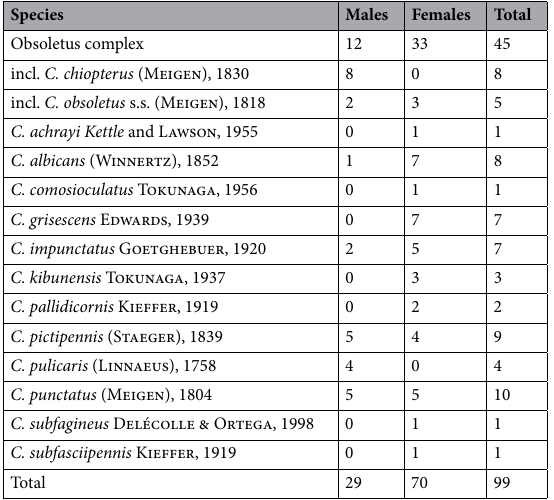
Table 2. Total numbers of Culicoides spp. and gender composition from all study sites.